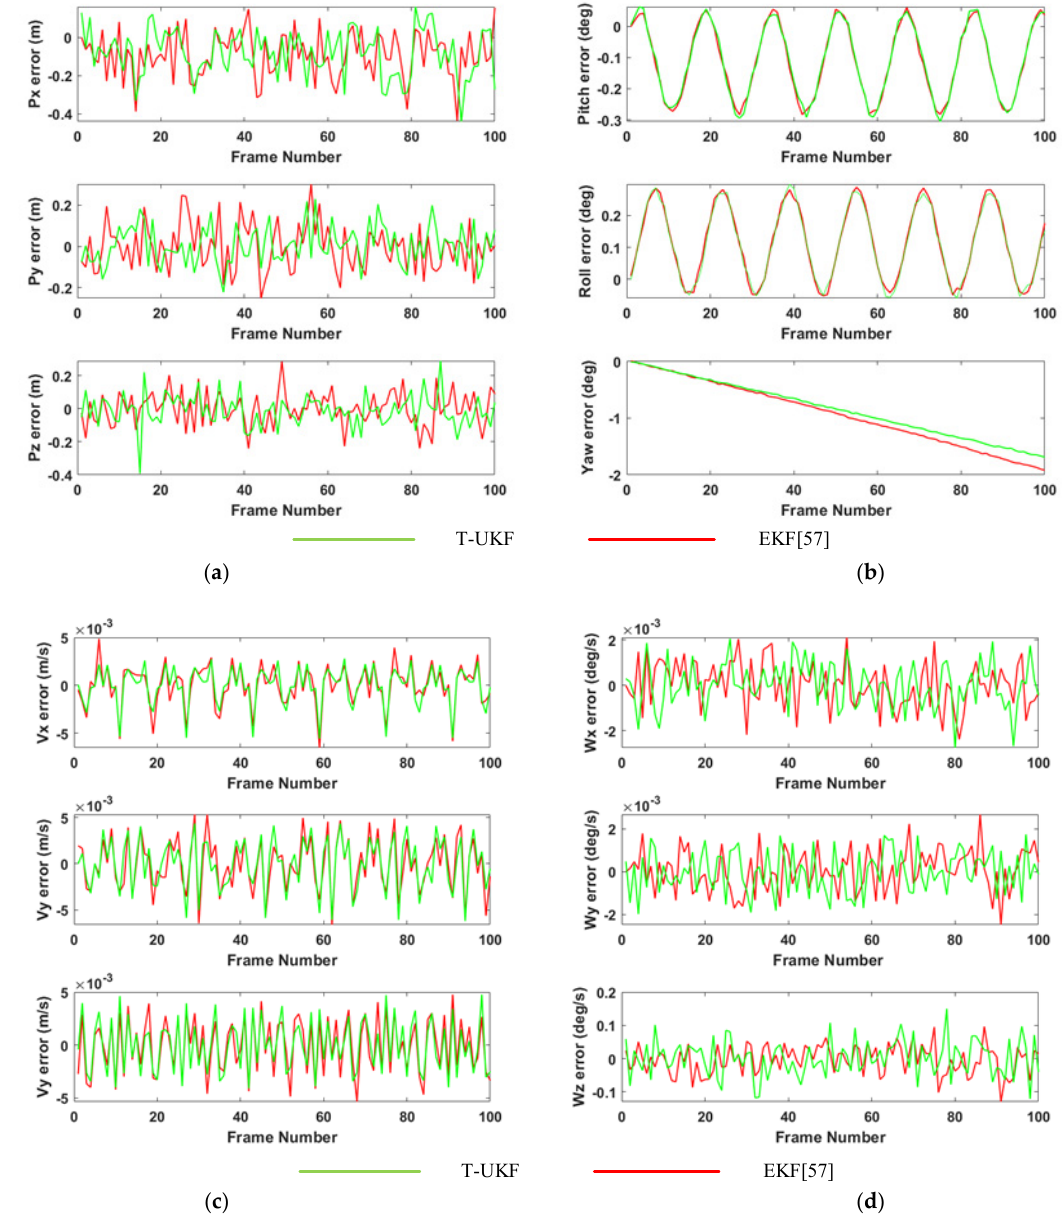
Figure 14. Comparison of the ( a ) translational position, ( b ) rotation angle, ( c ) velocity, and ( d ) angular velocity estimation errors of the proposed algorithm and a previously reported algorithm[57].